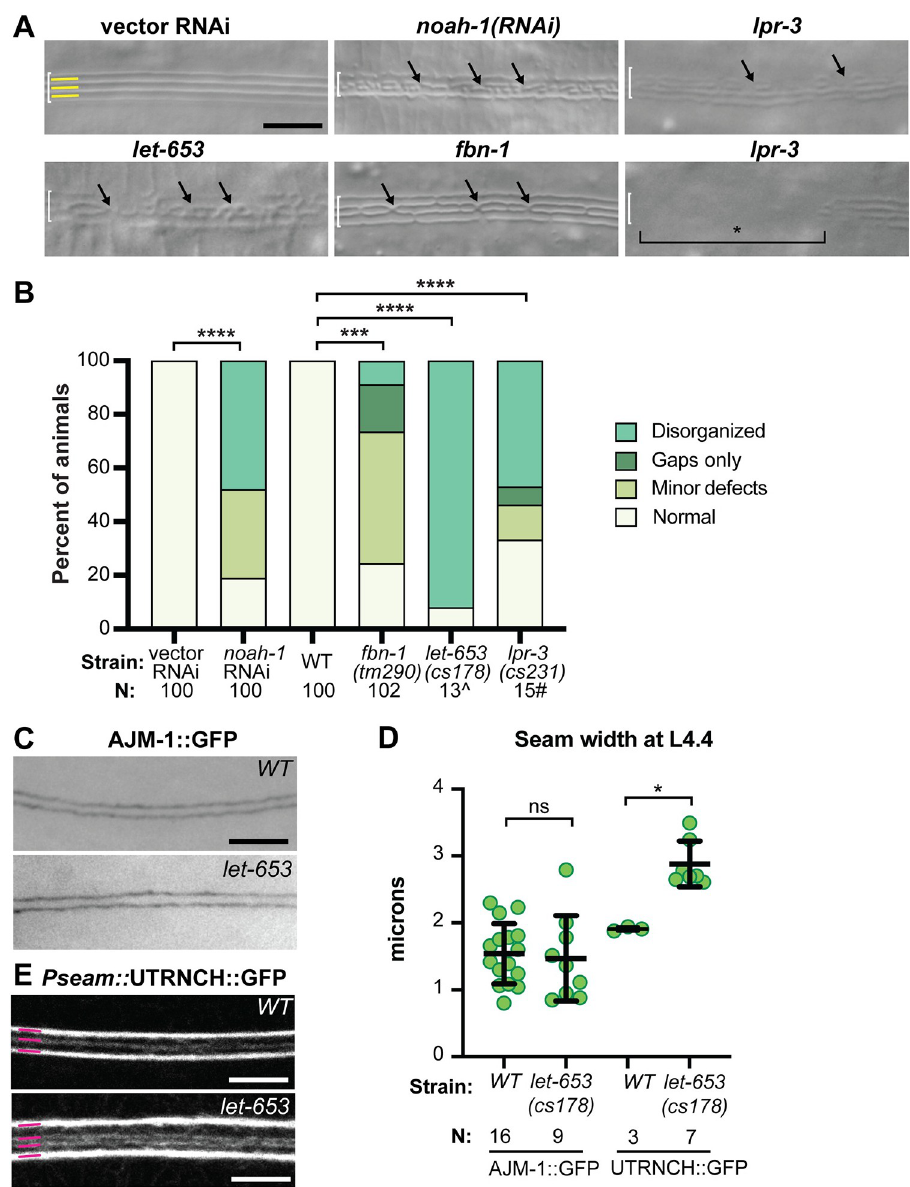
Fig 6. Provisional matrix components are required for patterning the alae. (A) DIC images of alae in RNAi knockdowns or mutants of the indicated genotypes (Strains N2 and ARF251, 25˚C; strains UP3184 and UP3452, 20˚C). Arrows indicate disorganized regions. Bracket indicates a large gap where no alae are present. (B) Quantification of alae defects, as in Fig 2D. ���� P < 0.0001, Fisher’s exact test. ^Data reproduced from [20]. # Numbers here are an under-estimate of the true penetrance of alae defects because not all mosaics would have lost lpr-3 in the seam lineage (see Materials and Methods). (C) At L4.4 stage, seam width (visualized with AJM-1::GFP) is similar between WT (strain SU93) and let-653(cs178) mutants (strain UP3184), both at 20˚C. (D) Measurements were performed as in Fig 3B, using either AJM-1::GFP or the actin sensor UTRNCH::GFP to assess seam margins. WT datapoints for AJM-1::GFP are re-used from Fig 3B. let-653 genetically interacted with the actin sensor to widen the seam. ns = not significant. � P < 0.05, Mann-Whitney test. (E) At L4.4 stage, longitudinal AFBs (visualized with Pseam:: UTRNCH::GFP) were present in both WT (strain ARF505) and let-653(cs178) mutants (strain UP4195), both at